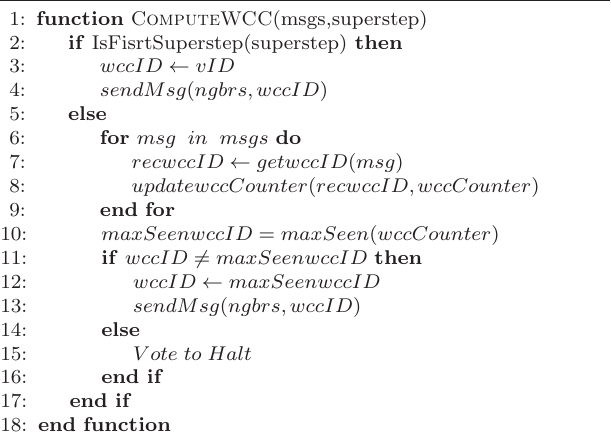
Algorithm 1 Vertex-Centric Implementation of PageRank